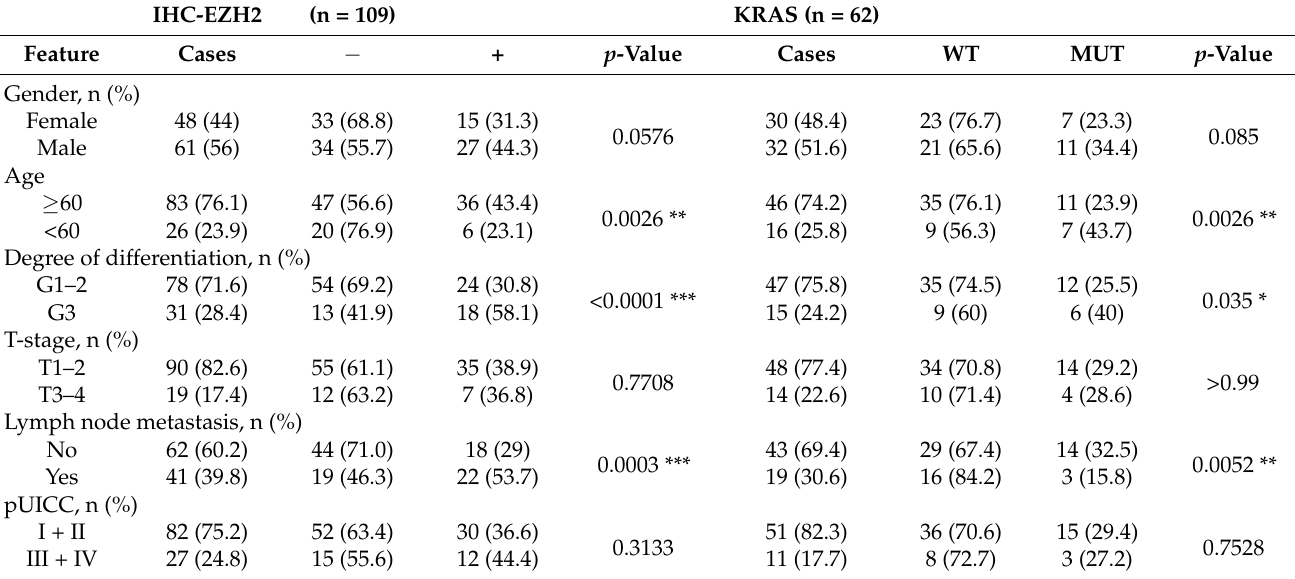
Table 2. Correlation of EZH2 expression and KRAS mutation with clinicopathologic